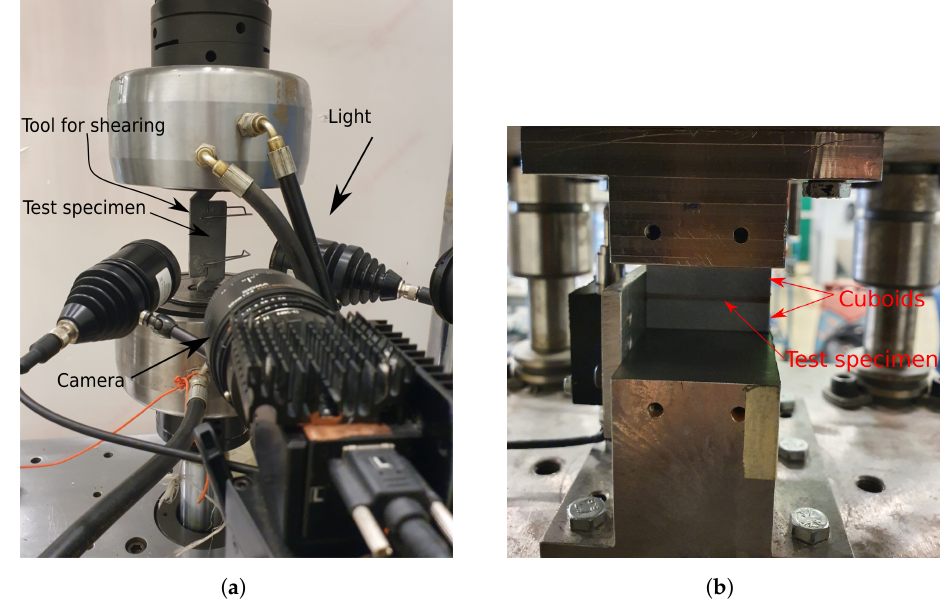
Figure 6. The experimental setup used for LCs 1 and 3–5 is presented in ( a ), with the test tool for shearing mounted in the machine. In ( b ), the experimental setup used of LC 2, i.e., compression, is presented. In both setups DIC was